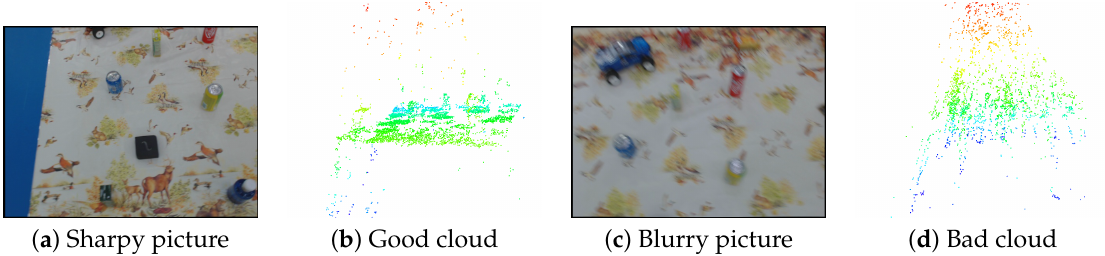
Figure 10. ( a ) shows a good input image. A point cloud generated from good images is shown in ( b ); where the floor plane is clear with objects protruding out; ( c ) shows a blurry image that generates a poor quality cloud ( d ); where the floor and objects are indistinguishable. A similarly bad cloud is also generated when images are mistimed too